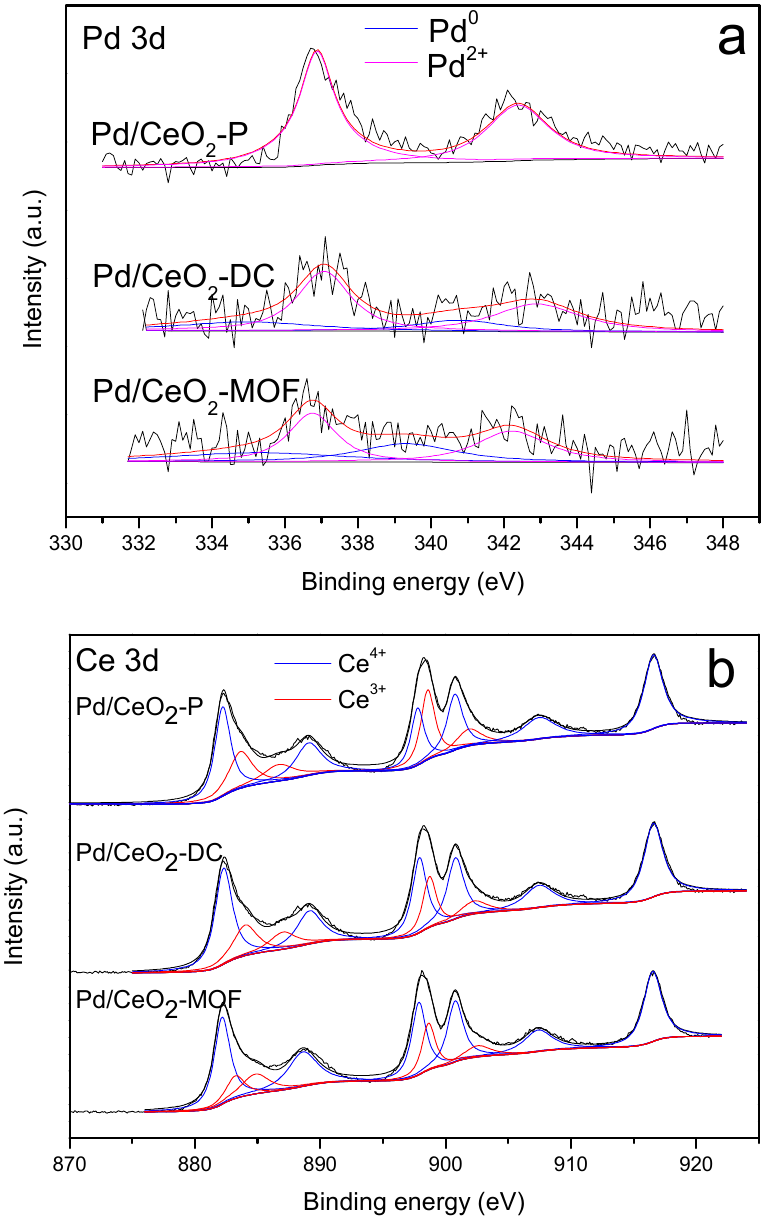
Figure 6. XPS spectrum: ( a ) Pd 3d; ( b ) Ce 3d. Table 2. Summary table of XPS characterization result of catalysts.